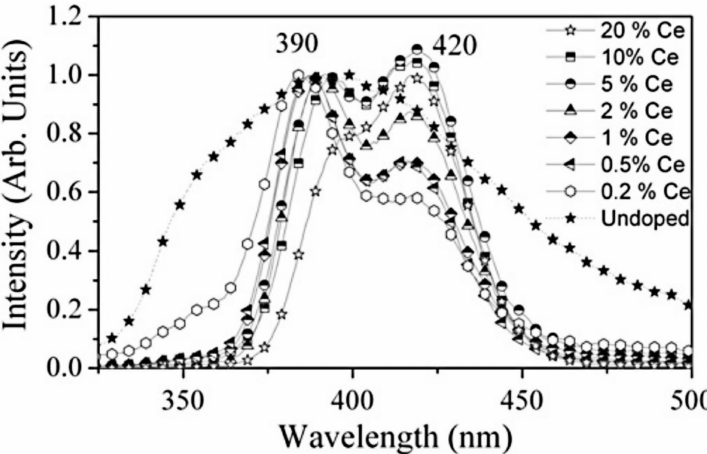
Figure 8. X-ray-induced emission spectra measured for CLLB samples with varying Ce 3+ concentra- tion ranging from 0 to 20%. Philips X-ray generator and C31034 photomultiplier tube (PMT) were used [13]. Copyright 2010, Elsevier B.V.